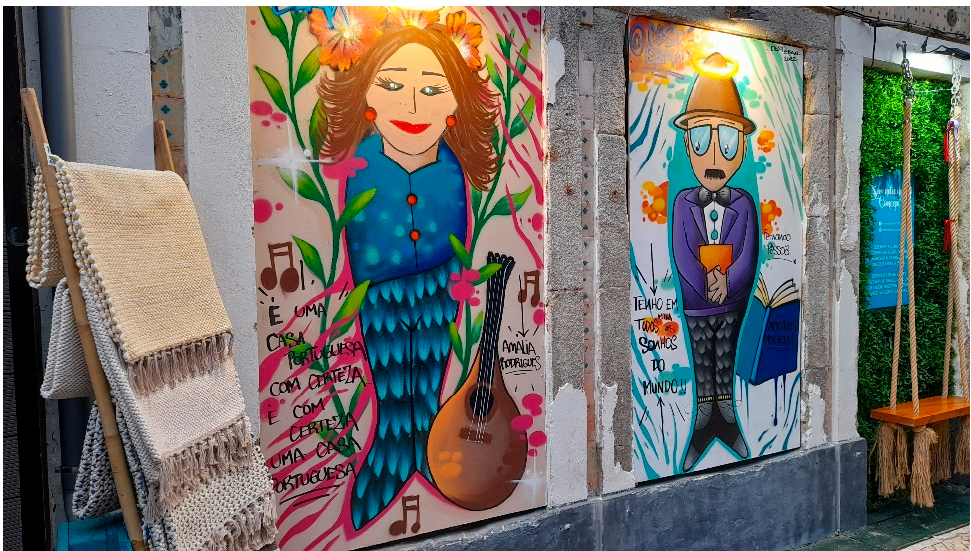
Figure 5. Am á lia Rodrigues and Fernando Pessoa, by street artist Cest Esteban, 2022 (Source: author’s own photo,